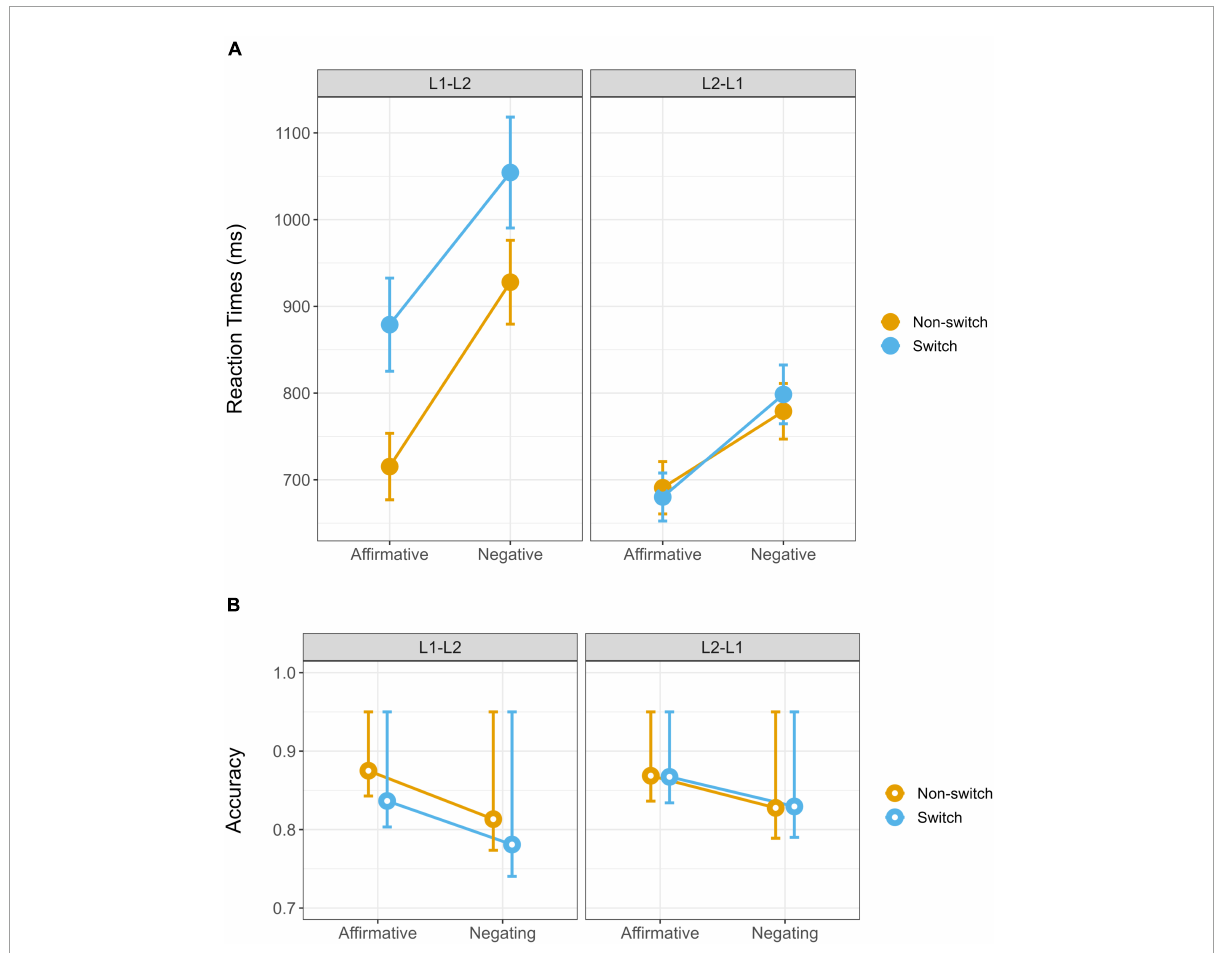
FIGURE1 Mean RTs (A) and accuracy (B) for response polarity (affirmative vs. negative) language sequence (switch vs. non-switch) and context language (L1 vs. L2).